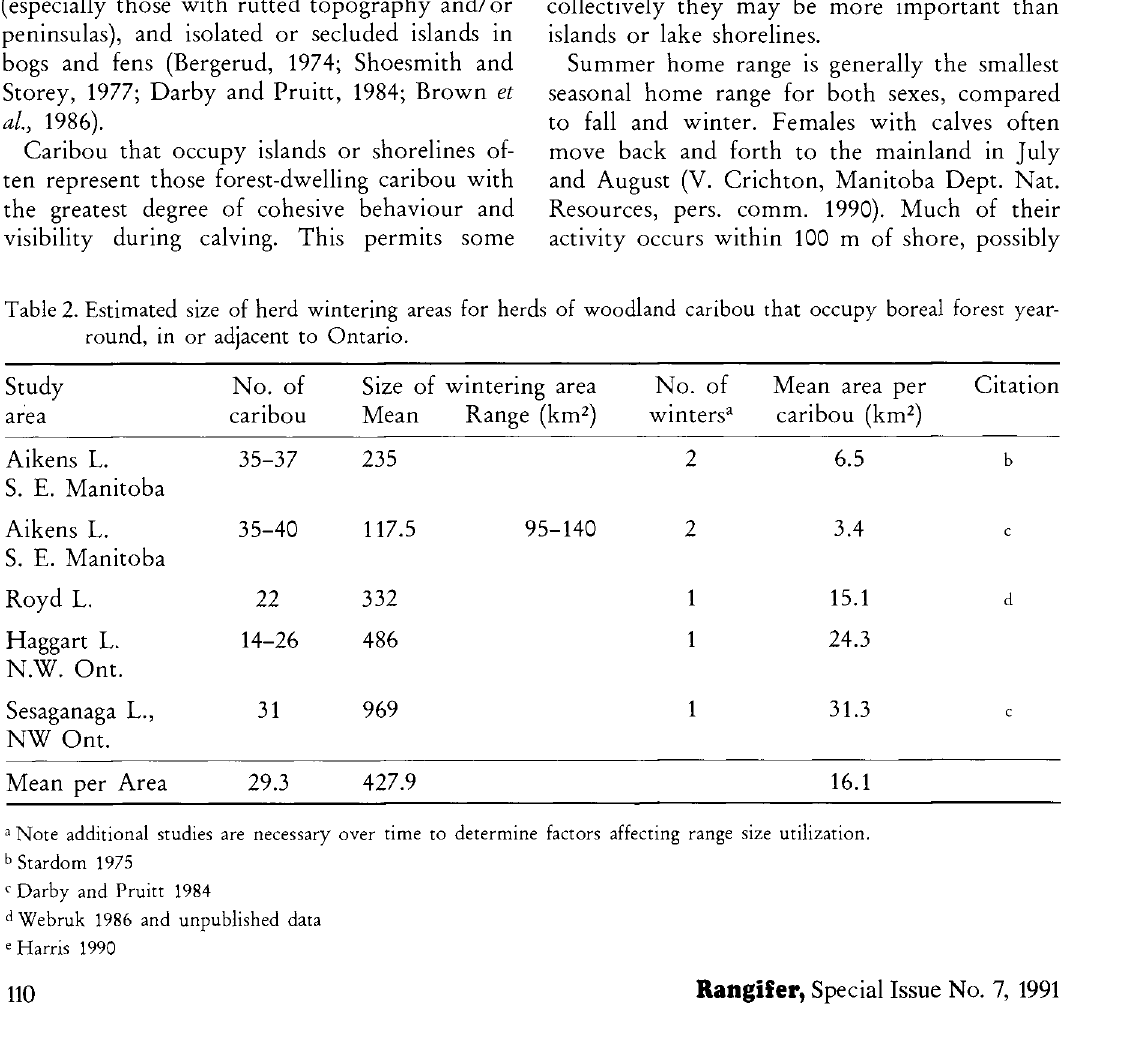
Table 2. Estimated size of herd wintering areas for herds of woodland caribou that occupy boreal forest year- round, in or adjacent to